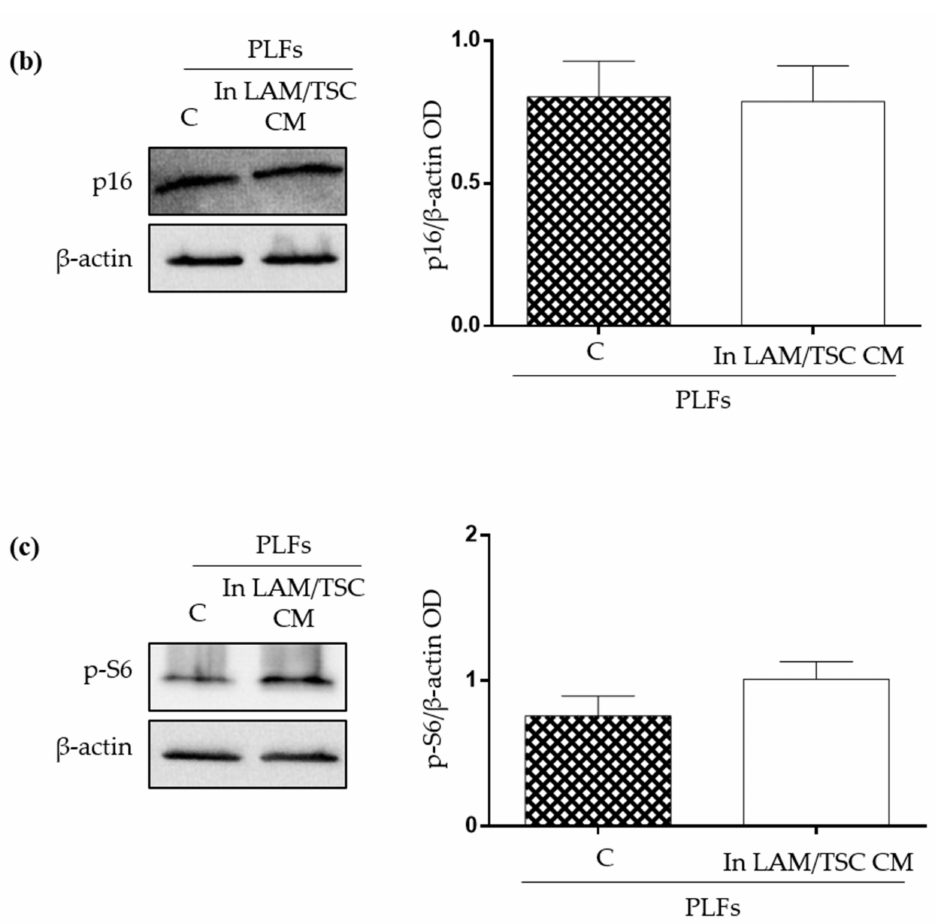
Figure 6. Evaluation of the effects of LAM/TSC cell CM on p21 WAF1/CIP1 and p16 INK4A expression and on S6 phosphorylation in PLFs. ( a ) p21 WAF1/CIP1 (p21) expression was analysed in PLFs grown for 48 h in their own CM (C) or in LAM/TSC cell CM. β -actin was used as loading control. Right panel: densitometric analysis of p21 WAF1/CIP1 / β -actin. Results are shown as mean ± SEM ( n = 3). Student’s t -Test, * p < 0.05. ( b ) p16 INK4A (p16) expression was studied in PLFs grown for 48 h in their own CM (C) or in LAM/TSC cell CM. β -actin was used as loading control. Right panel: densitometric analysis of p16 INK4A / β -actin. Results are shown as mean ± SEM ( n = 3). Student’s t -Test, ns . ( c ) The phosphorylation of S6 (p-S6) was analysed in PLFs grown for 48 h in their own CM (C) or in LAM/TSC cell CM. β -actin was used as loading control. Right panel: densitometric